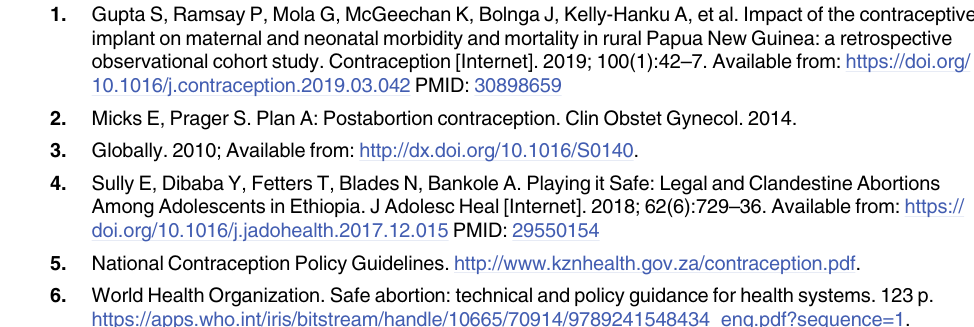
S3 Table. Actual and predicted values of abortion using linear regression